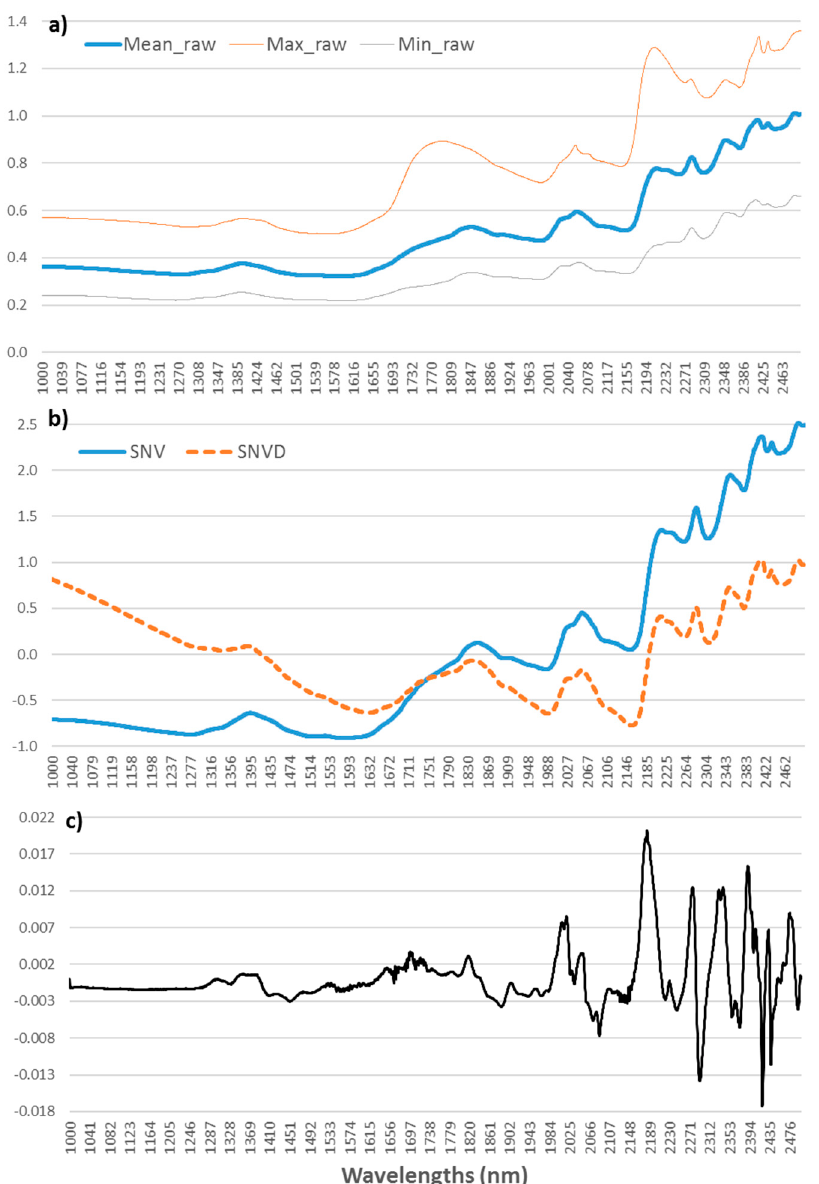
Figure 1. ( a ) Average (bold line), maximum and minimum (thin lines) of raw NIR spectra. ( b ) Standard normal variate (SNV) and standard normal variate plus detrending (SNVD) pre-treatments. ( c ) SNVD and first-order derivative pre-treatments. Spectra were recorded as log(1/R).